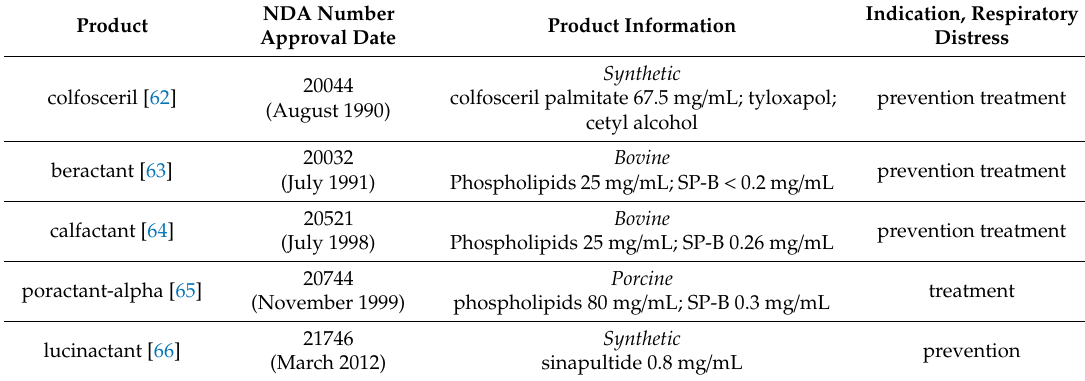
Table 4. Surfactant products approved by the FDA for prevention and / or treatment of Respiratory Distress Syndrome (RDS) (NDA = new drug